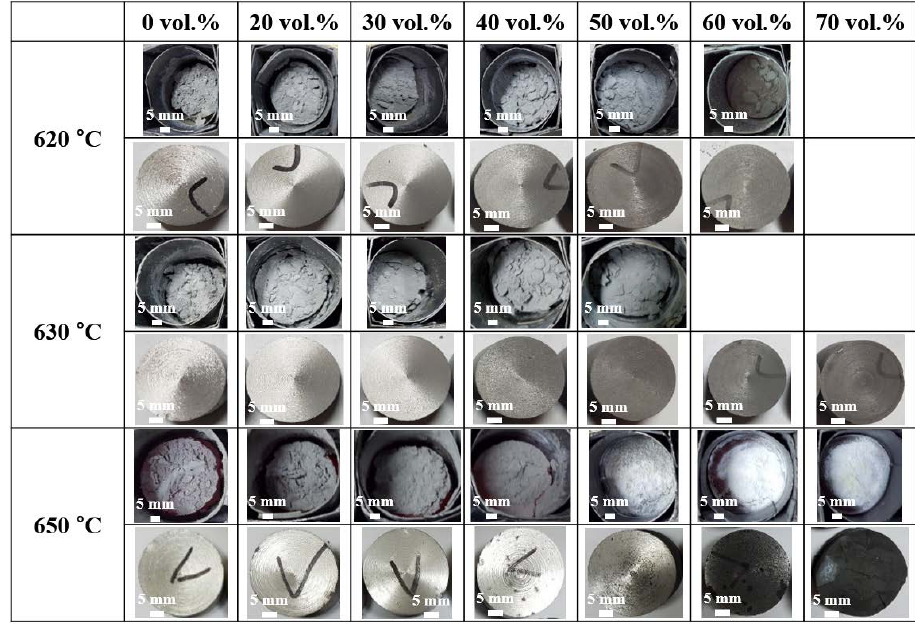
Figure 5. Photographic images of the 0–70 vol.% SiC (20 µ m)/6061Al composites in their crucibles immediately after heating for 1 h at various temperatures (620–650 °C) and air-cooling (upper rows), and images of the composites after machining (lower rows). Table 2. Degree of nitridation of the 0–70 vol% SiC (20 µ m) / 6061Al composites heated at 620–650 ◦ C for 1